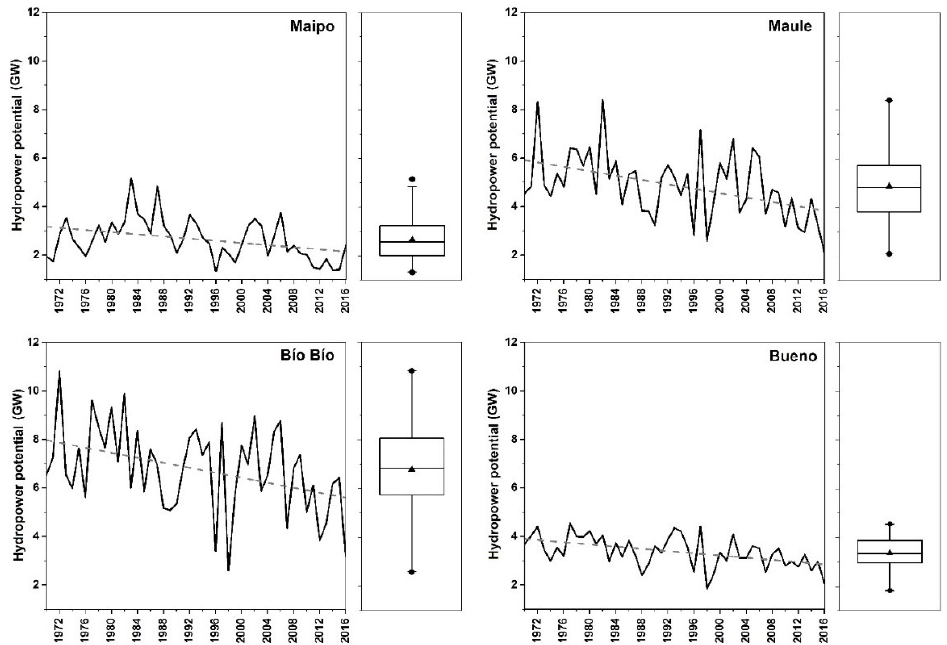
Figure 6. Time evolution of hydropower potential, and corresponding boxplots, between 1970 and 2016 in the four study basins. Dashed lines represent the trend. In the box plots, black circles show the maximum and minimum values, while the black triangle represents the mean value.